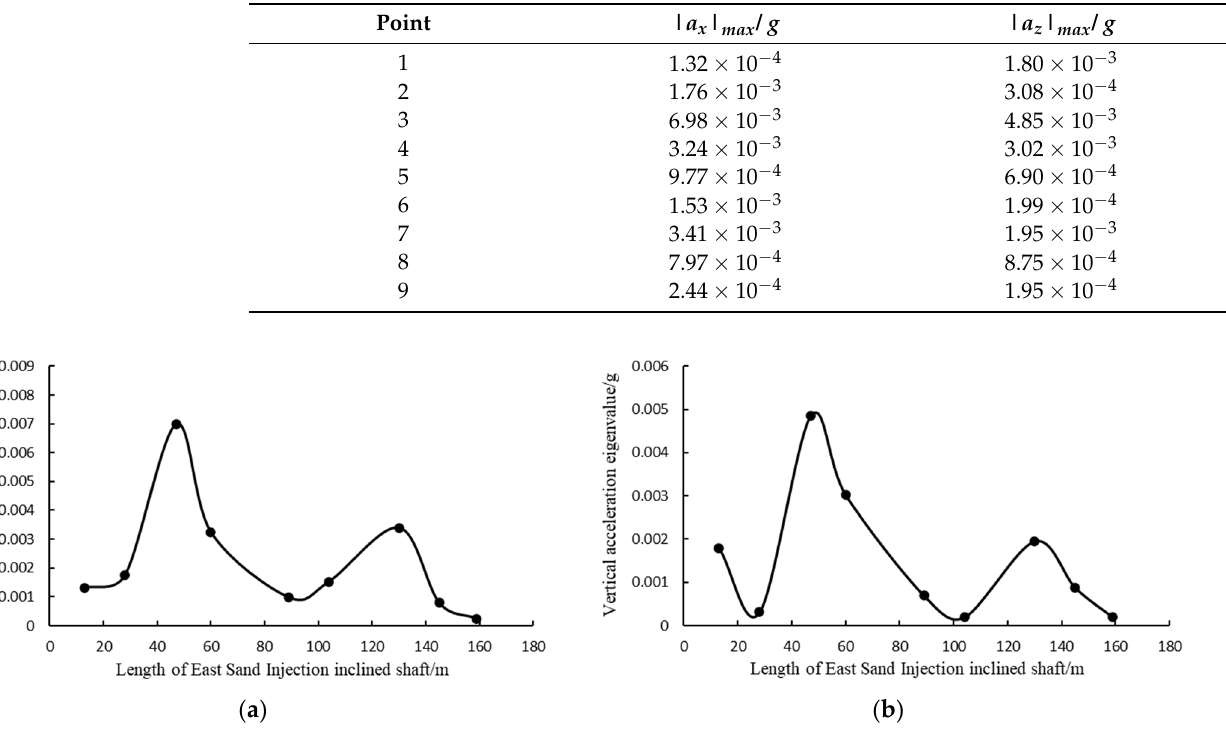
Table 3. Eigenvalue of acceleration of east injection inclined shaft.